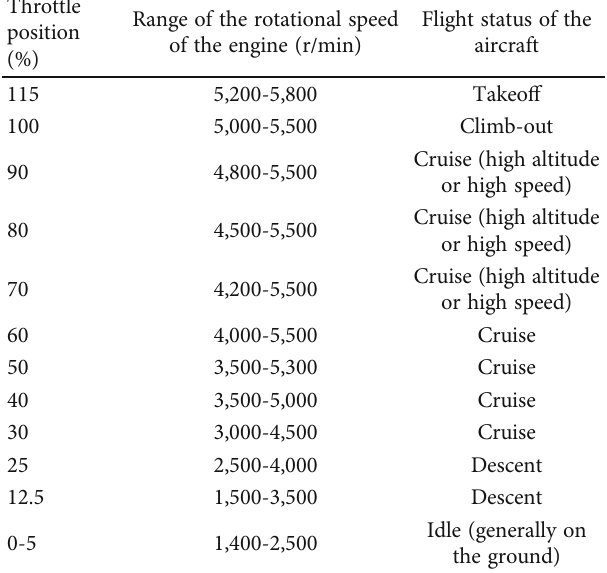
Table 2: Flight envelope requirements for a UAV.